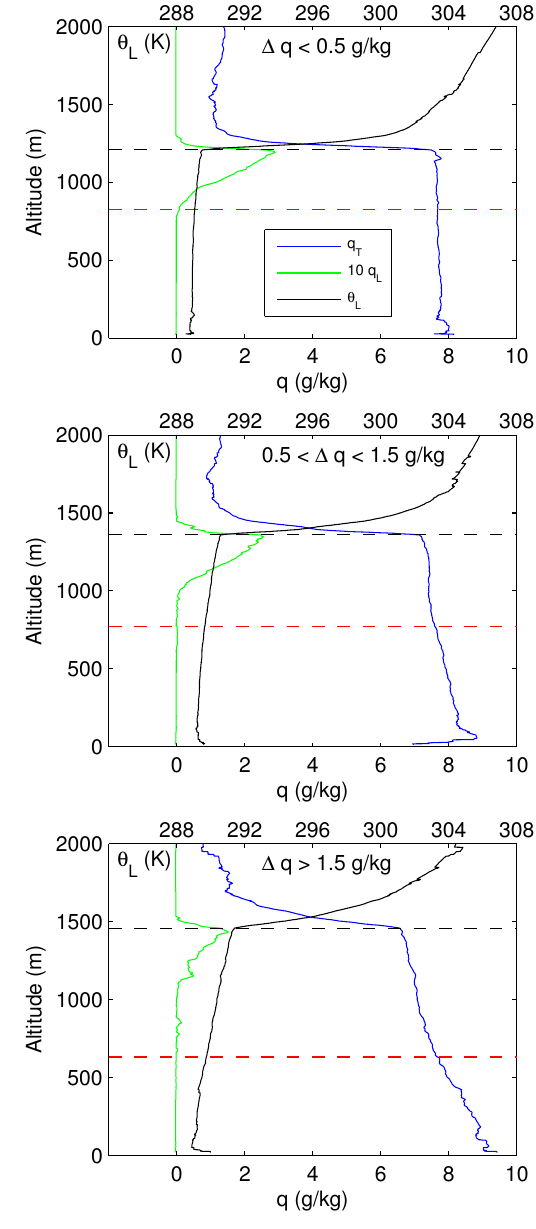
Fig. 4. Composite VOCALS-REx profiles for 1q < 0 . 5gkg − 1 (top), 0 . 5 < 1q < 1 . 5gkg − 1 (center), and 1q > 1 . 5gkg − 1 (bot- tom). The mean inversion is indicated by the dashed black line, and the mean LCL, determined from the bottom 25% of the boundary layer, is demarcated by the dashed red